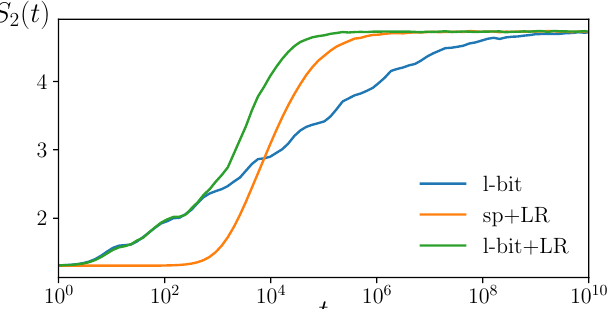
( t ) as a function of time for the l − bit model of Eq. (12) Figure 8: Renyi entropy S 2 > 0, J = 0 (l-bit), (ii) J > 0, J > 0 (l-bit + LR ), (iii) J with (i) J 0 1 0 1 (sp + LR ), see legenda. The system size is K = 16 and the initial state